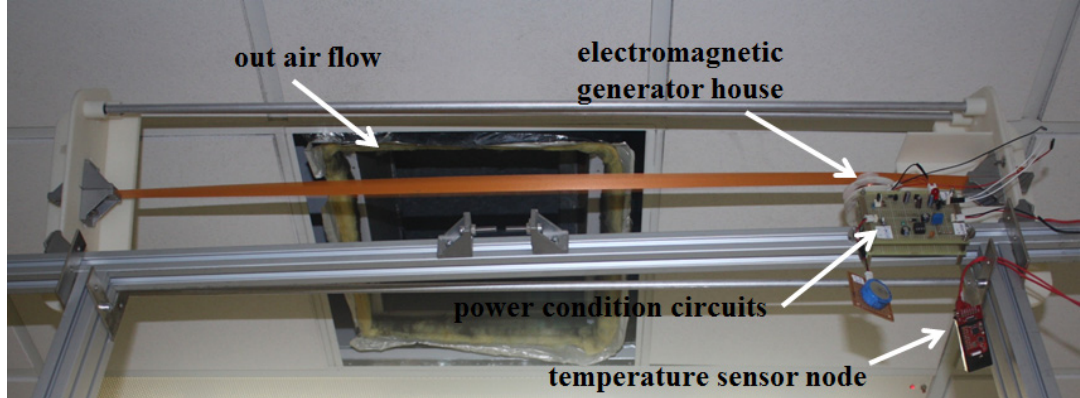
Figure 2. Indoor ventilation duct flutter energy harvesting